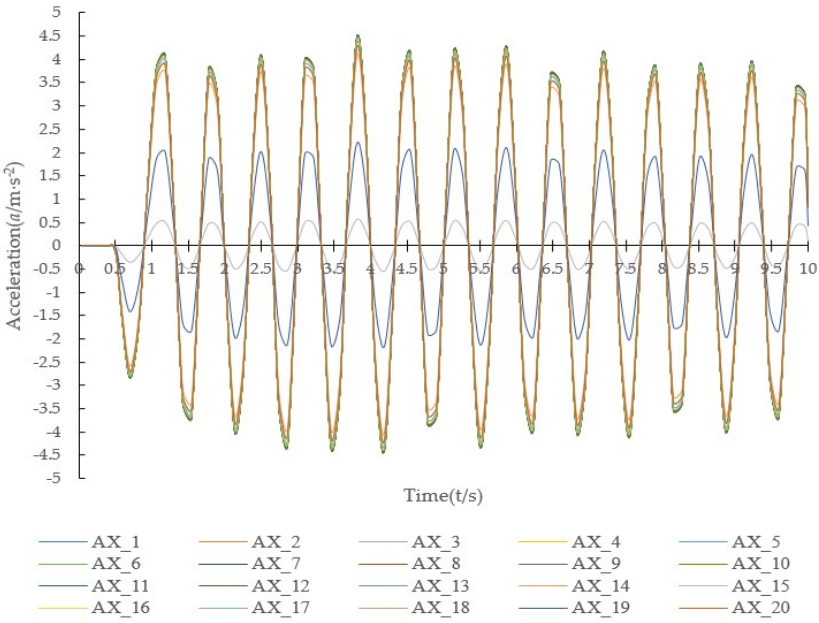
Figure 5. Acceleration response curves of no damage frame structure from No. 1 to No. 20 response points .